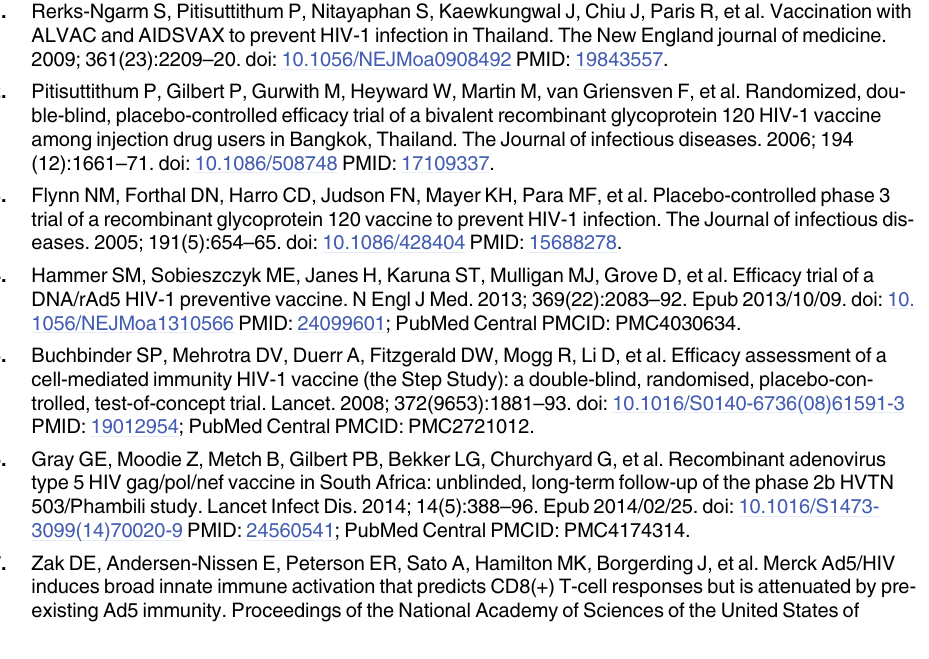
S1 Fig. Consort diagram of participant flow. (TIFF) S2 Fig. Consort diagram of evaluation of circumcision status among